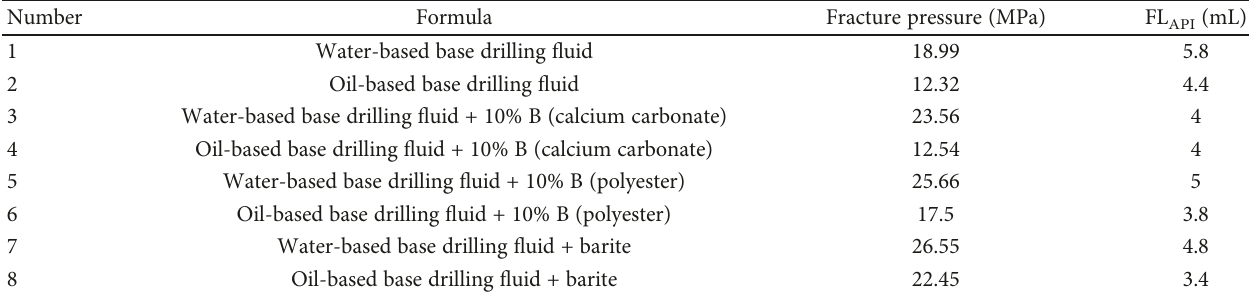
Figure 19: Mud cakes formed on the wall of the inner hole in the core. Table 8: Results of the core fracturing experiment for several di ff erent conditions of oil-based drilling fl uid and water-based drilling fl uid.